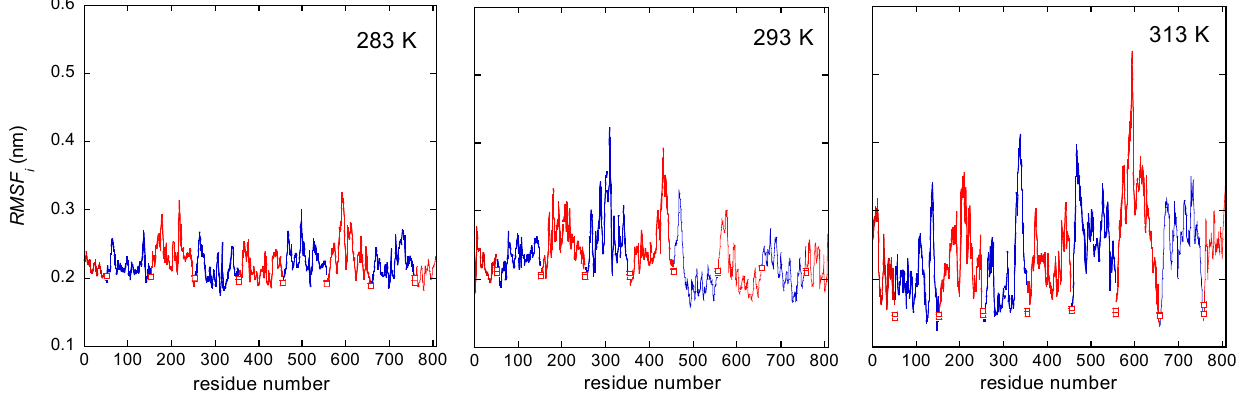
Figure 3. Root mean squared fluctuations of backbone carbon atoms. Squared symbols indicate PMA atoms. Red and blue lines refer to PVA atoms. Time window: last ns trajectory.